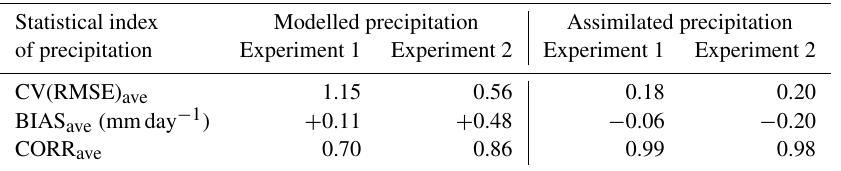
Table 3. Statistical indices for validation of modelled and assimilated precipitation by comparison with rain-gauge stations in the Ofanto basin.